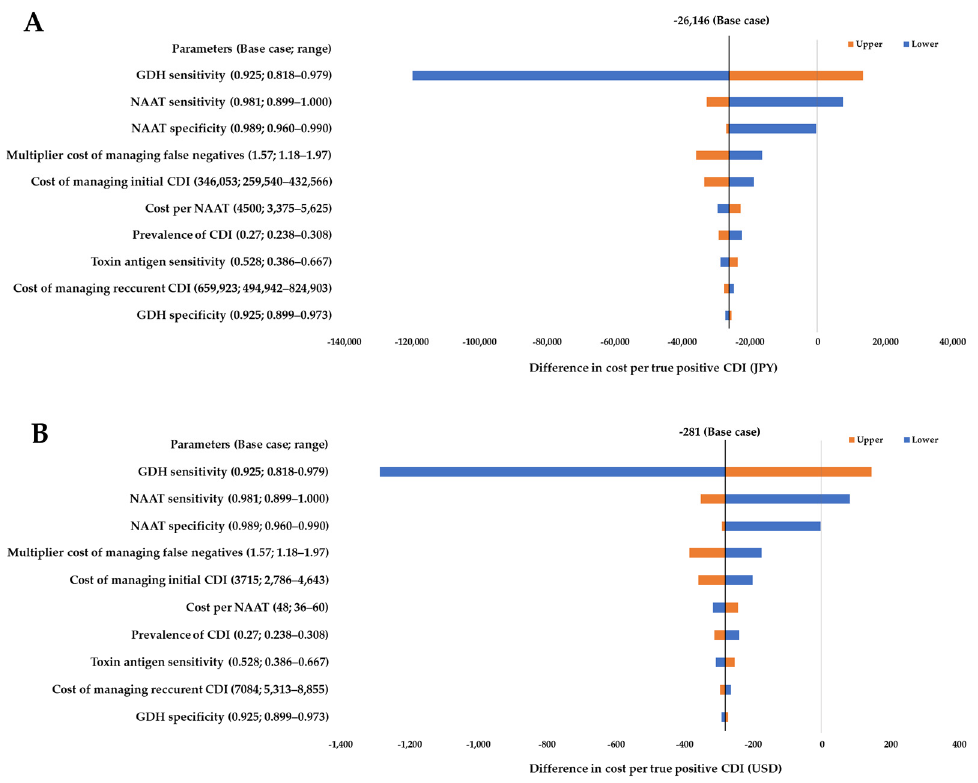
Figure 3. One-way sensitivity analysis for di ff erence in cost per CDI diagnosed in the NAAT alone pathway compared to the two-step algorithm in ( A ) JPY; ( B ) USD. Data parameters that are the most sensitive to changes in the base case estimate are listed in descending order. A value below 0 would represent cost savings when the NAAT alone pathway is used compared to the two-step